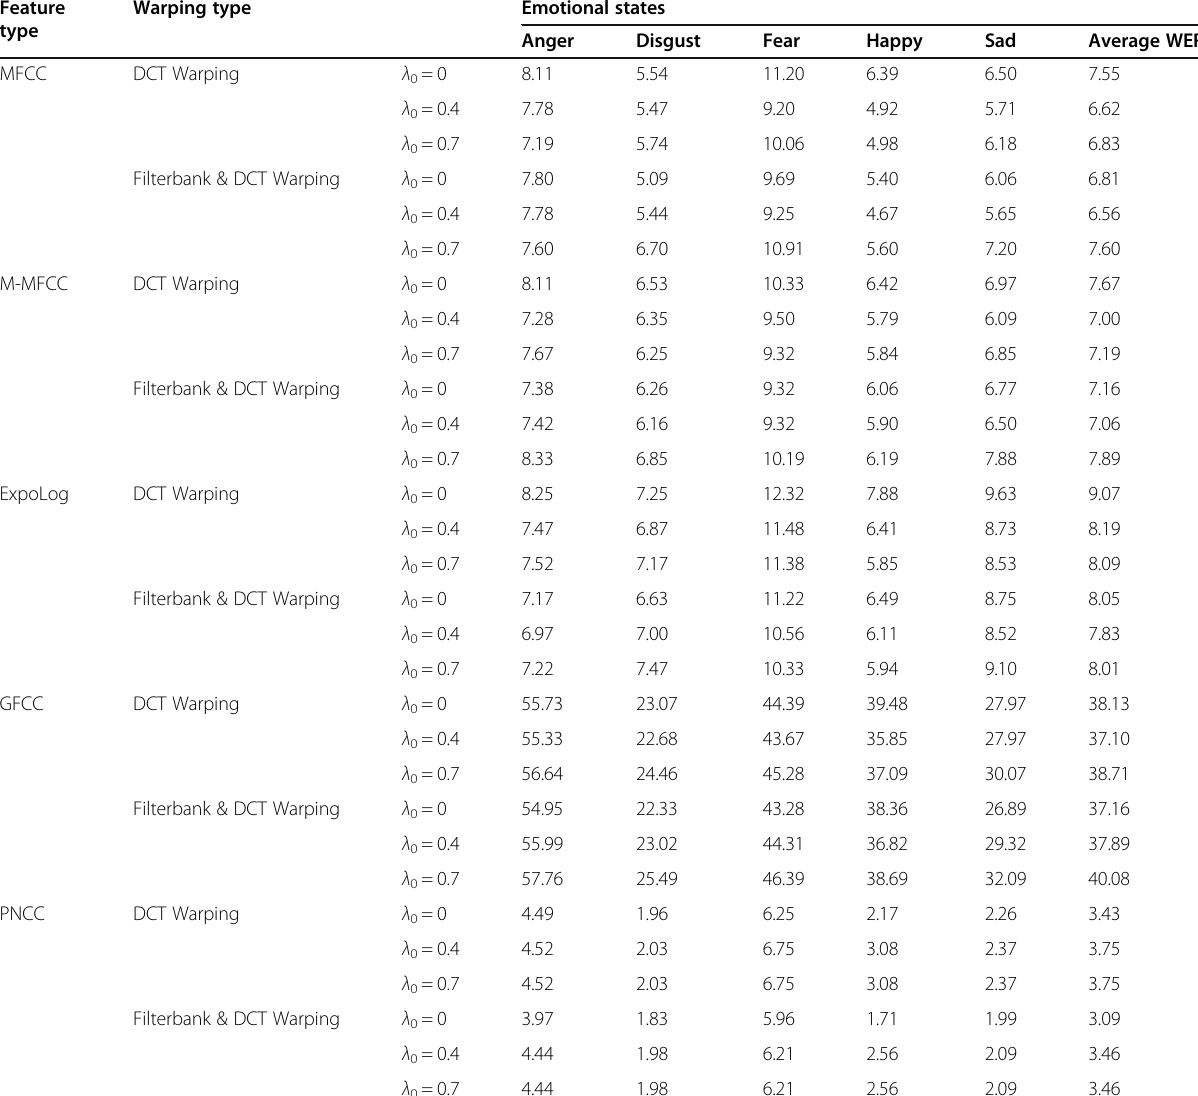
Table 3 The effect of modifying the normalized reference frequency, λ 0 , on the recognition performance of the proposed GMM- HMM EASR system (in terms of WER (%)) for CREMA-D. The values of WER are obtained by applying different warping methods to various acoustic features extracted from different emotional utterances Feature